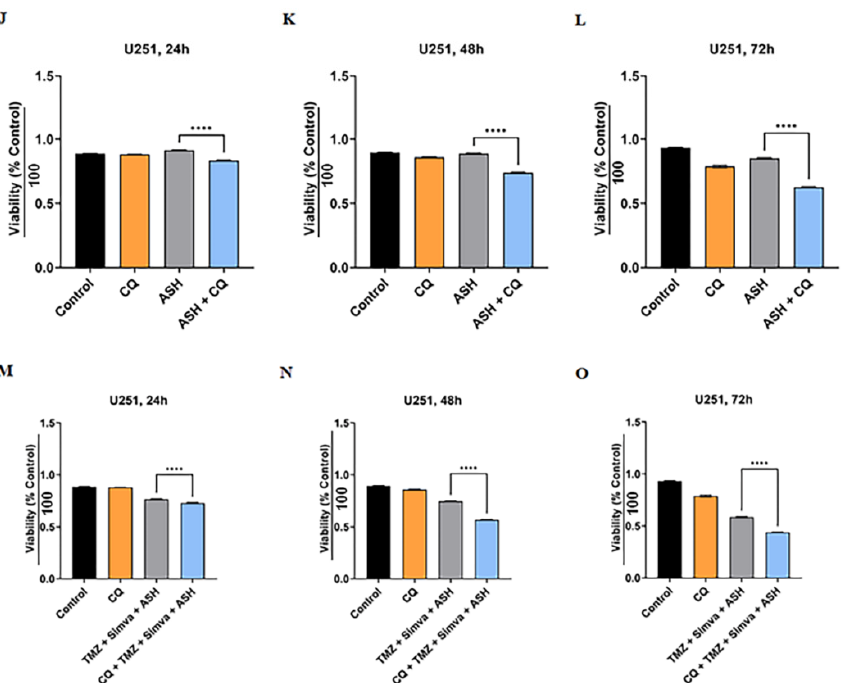
Figure 5. Autophagy flux inhibition increases simvastatin, temozolomide, acetylshikonin and triple- combination treatment-induced cell death. U251 cells were treated with different concentrations of chloroquine (CQ) (25–200 µ M) at 24, 48 and 72 h. Cell viability was assessed via an MTT test ( A – C ). CQ induced significant cell death for all concentrations at all time points (**** = p < 0.0001), except 25 and 50 µ M concentrations at 24 h ( p > 0.05). We used CQ 50 µ M in combination with Simva 1 µ M ( D – F ), TMZ 100 µ M ( G – I ), ASH 1.5 µ M ( J – L ) and TMZ/Simva/ASH ( M – O ) for 24, 48, and 72 h.